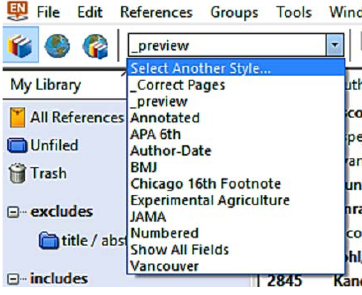
Figure 1 Activating the _preview